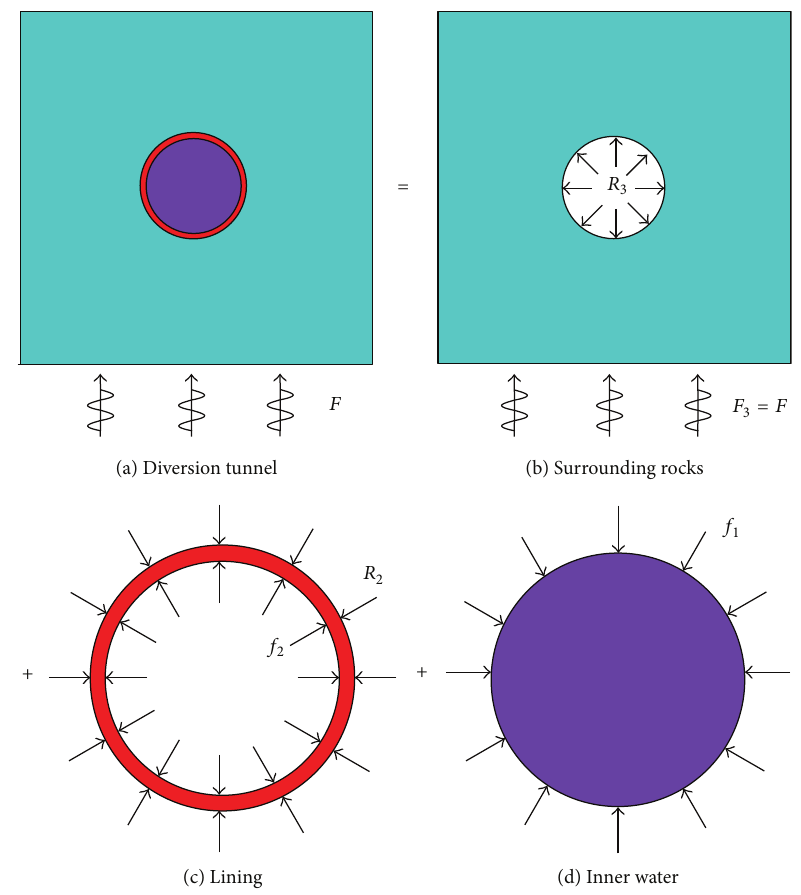
Figure 1: Seismic response analysis model of diversion